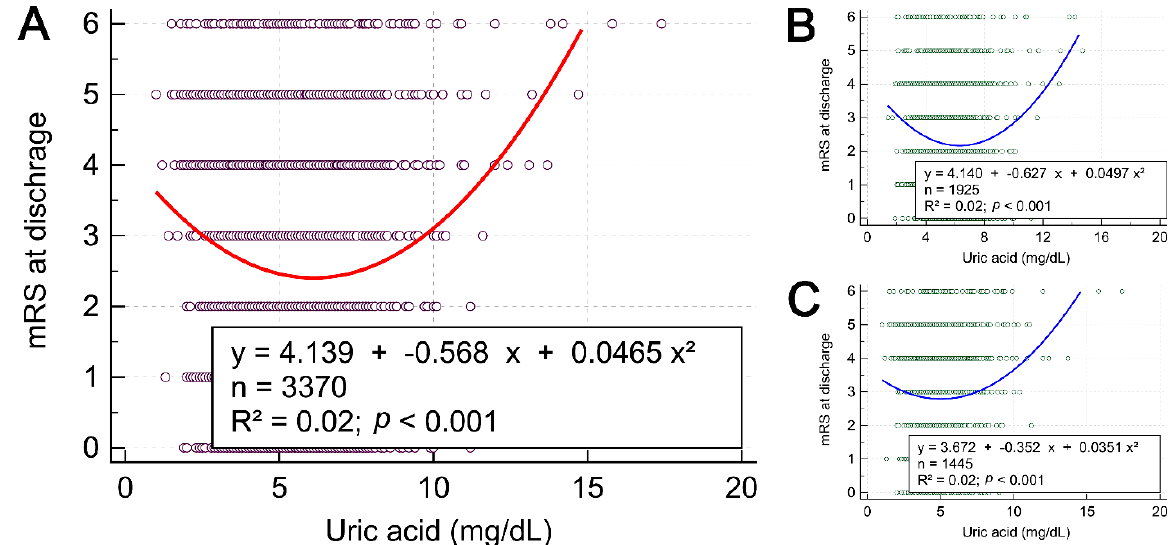
Figure 1. Least squares regression analyses show a J-shaped curve between uric acid and discharge modified Rankin Scale scores in all patients ( A ), in men ( B ), and in women ( C ). mRS, modified Rankin Scale. Table 6. Comparison of measured variables with different quartiles of uric